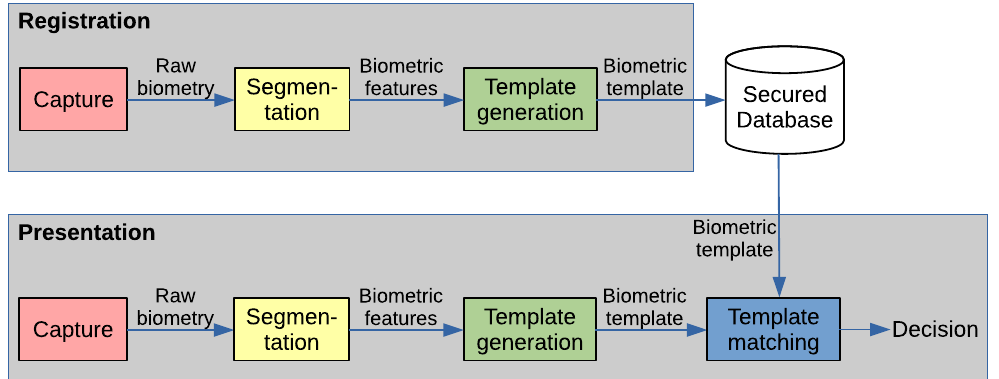
Figure 1. Biometric system